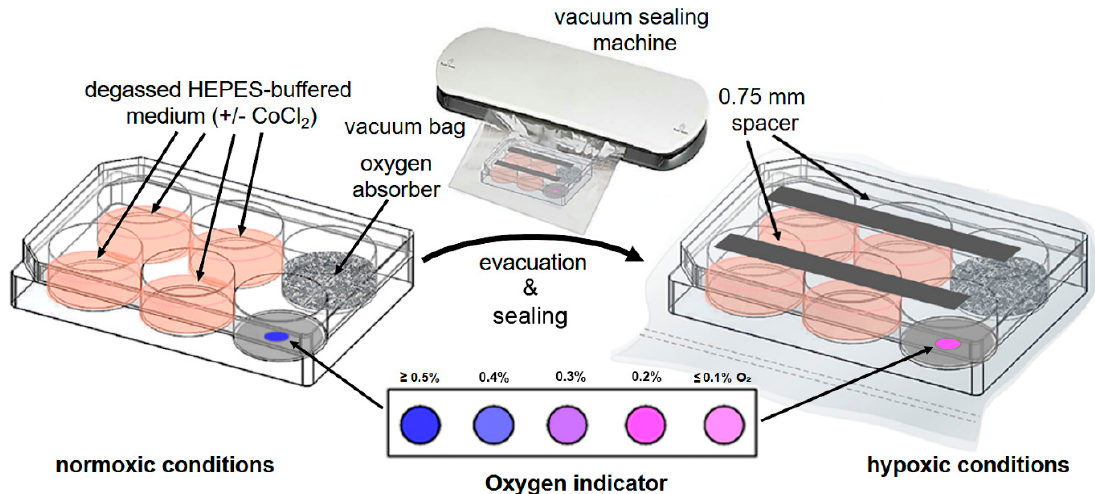
Figure 1. Sealed hypoxic cell culture plate. For hypoxic cell culture conditions, JAWS II cells are seeded under normoxic conditions in degassed, HEPES-buffered complete IMDM (selected wells are additionally supplemented with CoCl 2 ). Moreover, an oxygen absorber and an oxygen sensor (AgelessEye) are added to the 6-well plate to establish and monitor the low oxygen environment, respectively. Two sterile 0.75 mm plastic spacers placed on top of the 6-well plate allow gas exchange between the different wells of the cell culture plate. After the cell culture plate is closed with the lid, it is placed in a vacuum bag, evacuated from ambient air, and sealed using a vacuum sealing machine. Finally, the sealed hypoxic cell culture plate is then placed in a standard incubator at 37 ◦ C. When exposed to low oxygen ( ≤ 0.5% O 2 concentration), the oxygen sensor AgelessEye turns from blue to pink. This color change can be controlled/monitored throughout the cultivation of the cells.